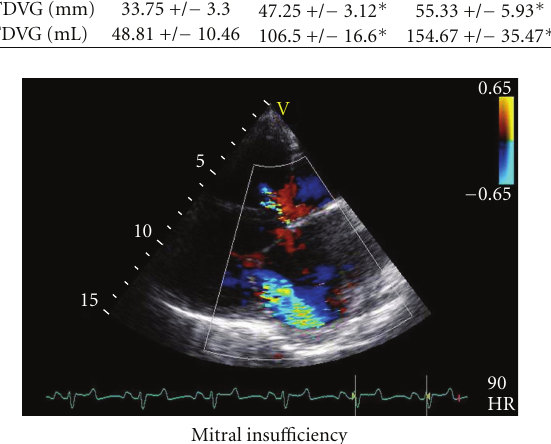
Figure 3: One to 2 months after constriction, the left ventricle dilates and a significant mitral insu ffi ciency